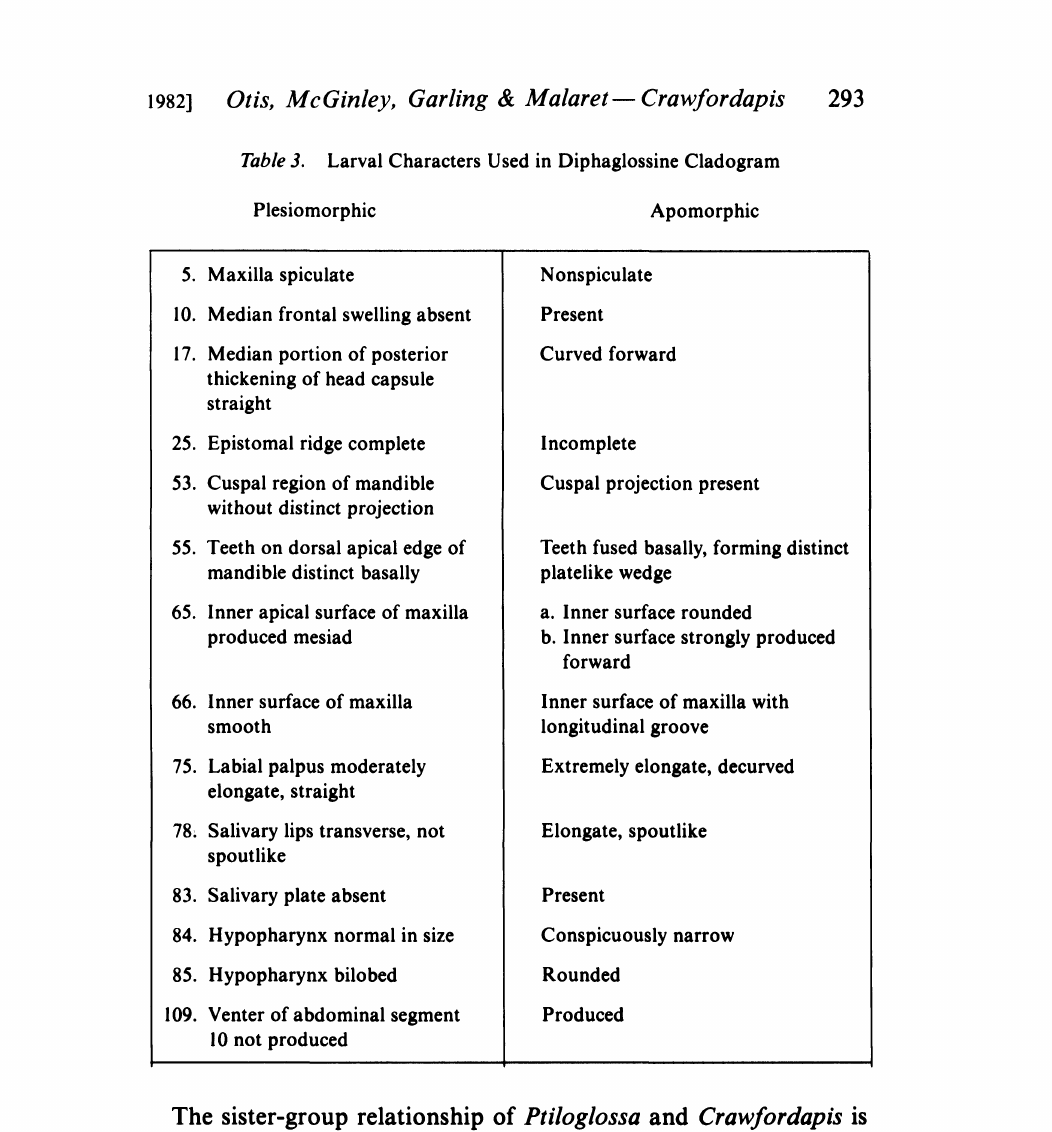
Table 3. Larval Characters Used in Diphaglossine Cladogram